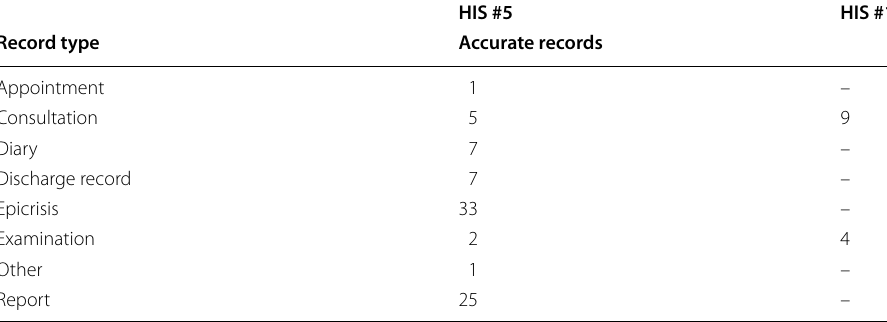
Table 4 Automatically retrieved accurate records for HIS #1 and HIS #5 according to subsection representations HIS #5 HIS #1 Record type Accurate